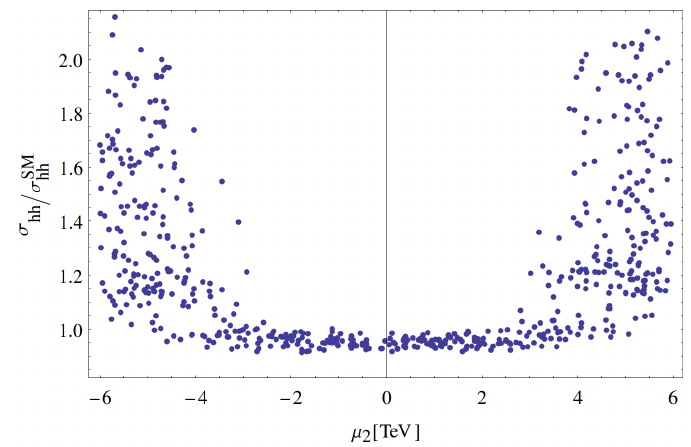
Figure 9. LO σ hh normalized with respect to the SM one, as function of µ 2